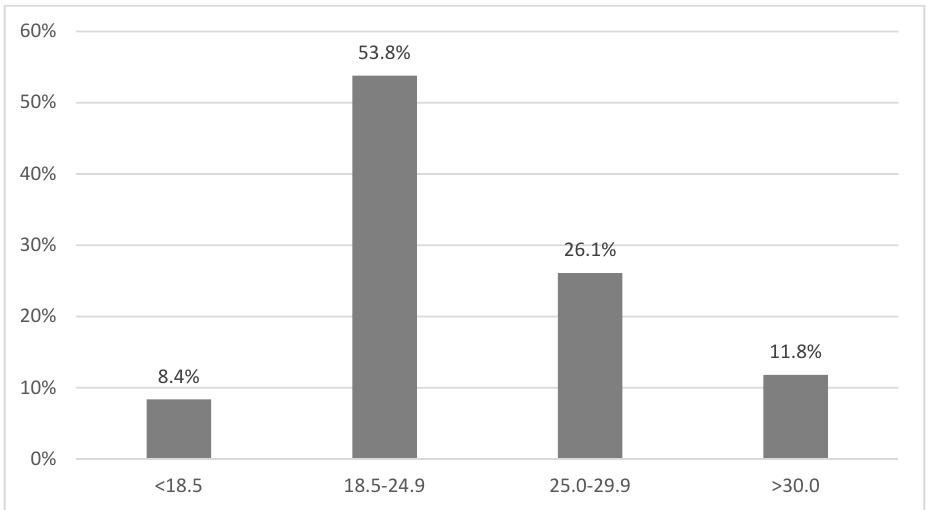
Figure 2. Distribution of BMI (kg/m 2 ) among the malnourished patients.